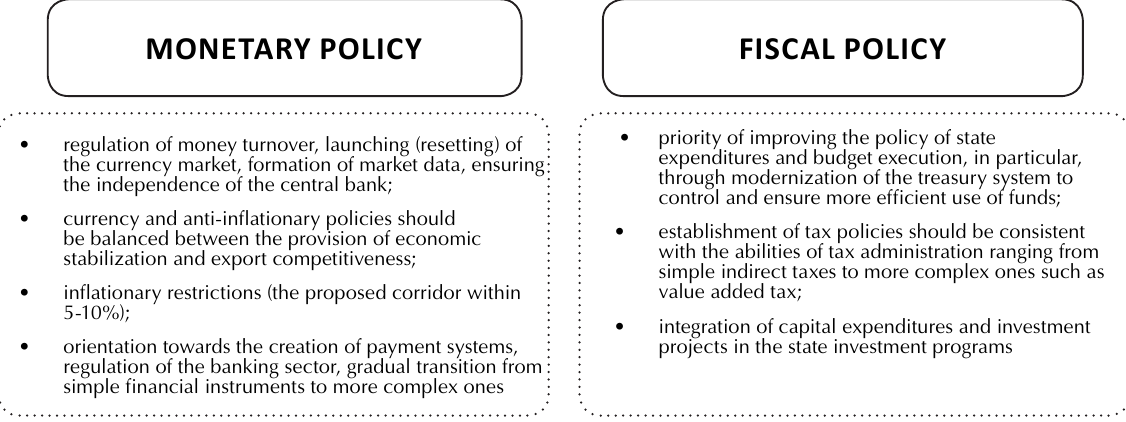
Figure 2. Some provisions of successful post-conflict economic recovery in the sphere of monetary and fiscal